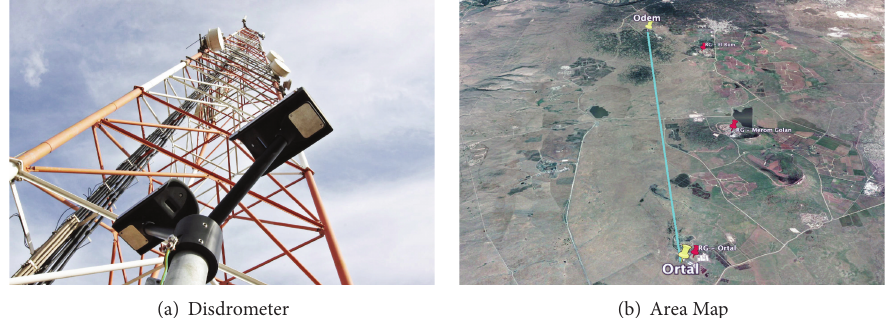
Figure 1: The installed OTT Parsivel Disdrometer Weather Sensor near Ortal’s MCN base-station tower (a), and the test area map showing the ML’s 12.08km path, as well as the three available RGs: RG-Ortal, RG-Merom-Golan and RG-El-Rom (b). (Image (a) was taken by Y. Dagan. Image (b) was created via Google Earth).